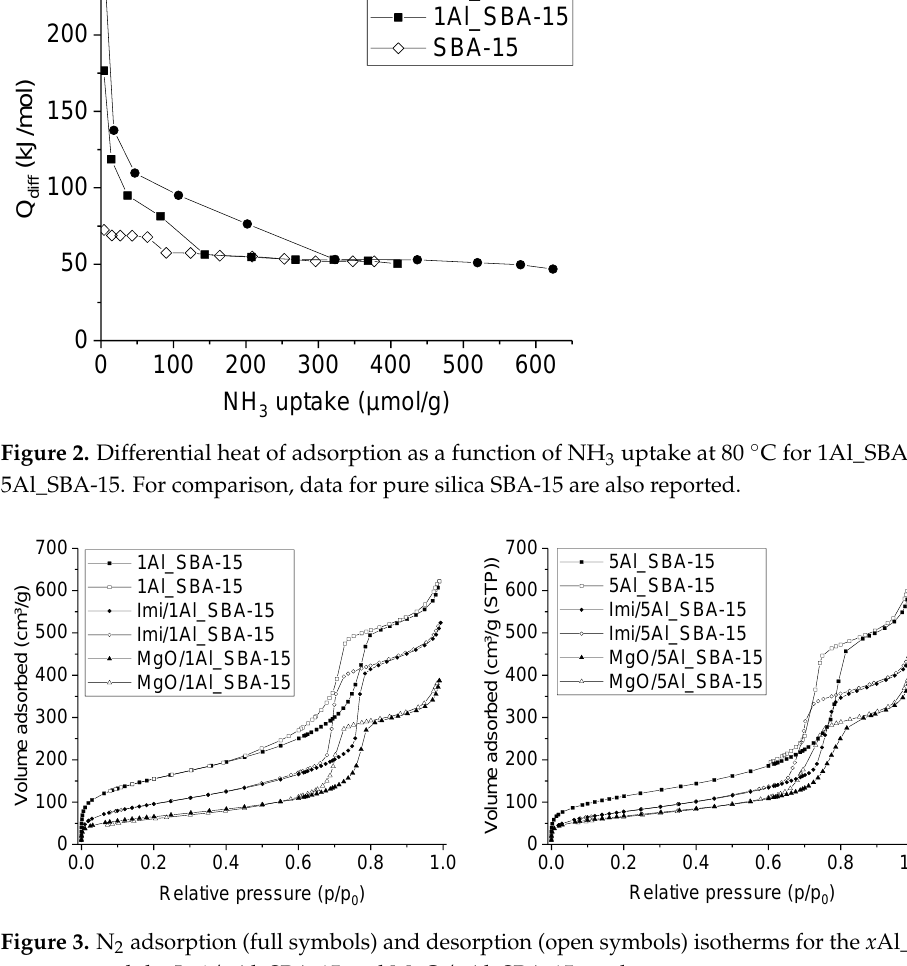
Figure 3. N 2 adsorption (full symbols) and desorption (open symbols) isotherms for the x Al_SBA-15 supports and the Imi/ x Al_SBA-15 and MgO/ x Al_SBA-15 catalysts.